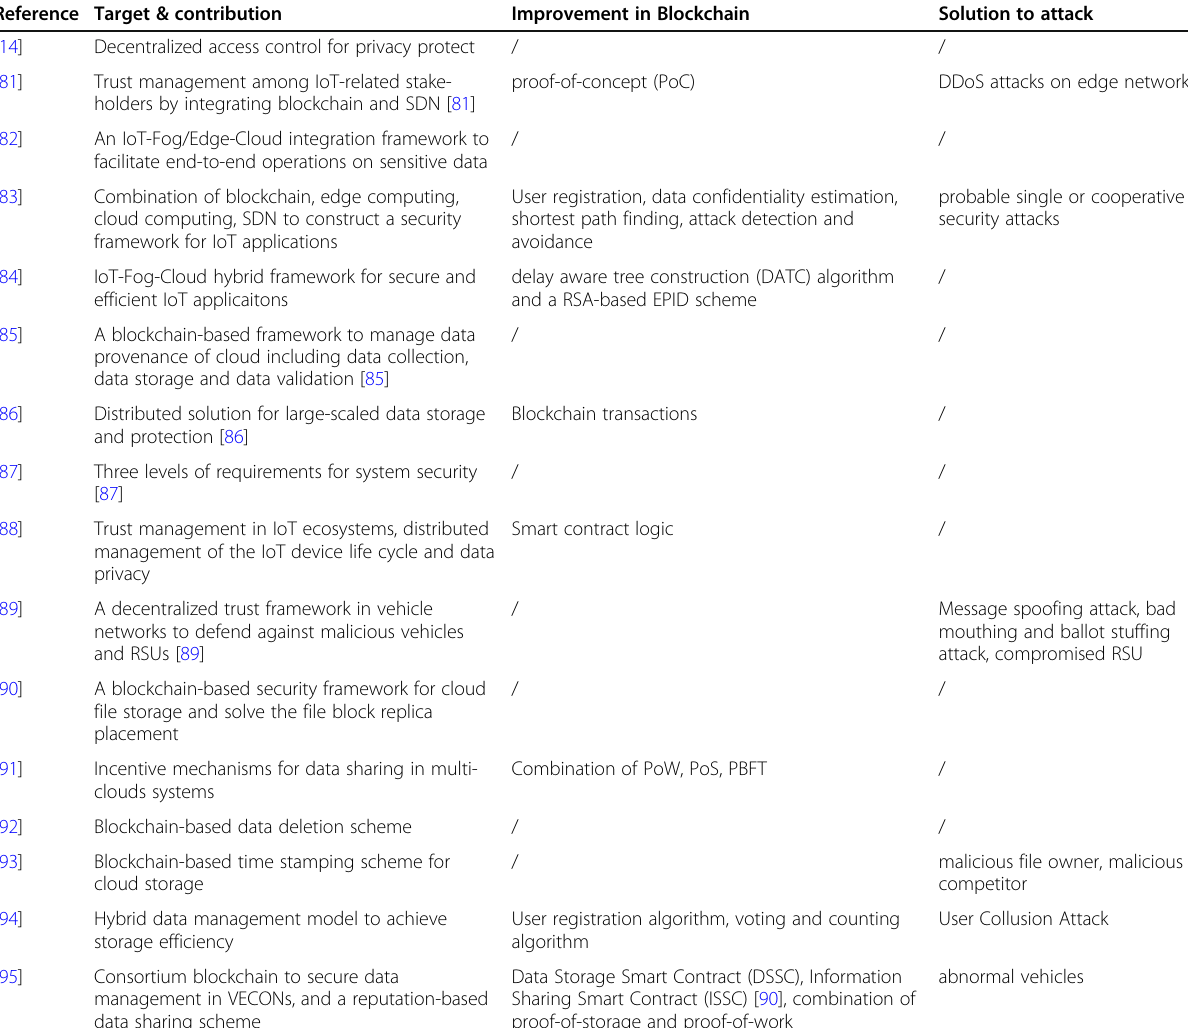
Table 9 Comparison of main contributions Reference Target &